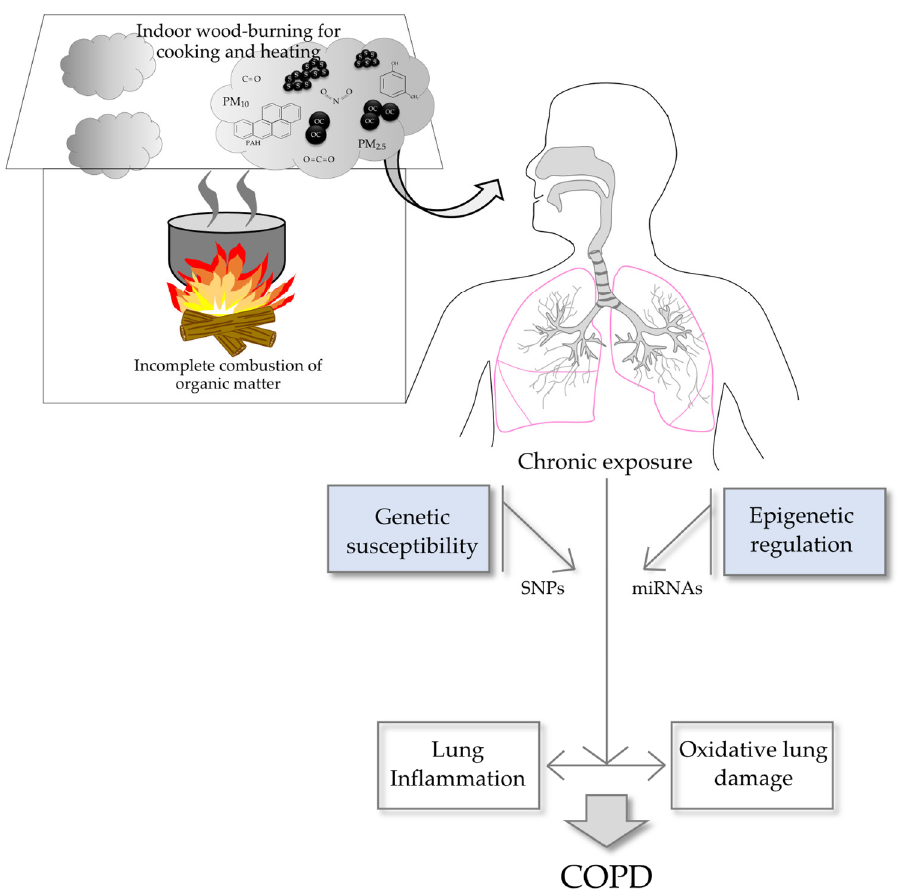
Figure 2. Biomass-related COPD is a complex and multifactorial disease that develops after the combination of chronic exposure to the hazardous components of woodsmoke and genetic and ep- igenetic factors of susceptibility. Organic carbon (OC), soot